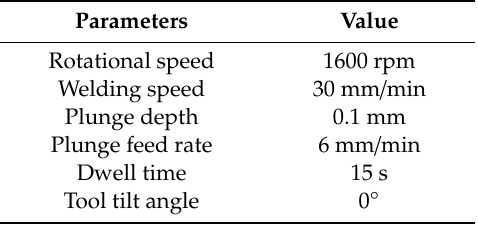
Figure 1. Experimental setup of friction stir welding on a Computer Numerical Control (CNC) machine. Table 3. Friction stir welding process